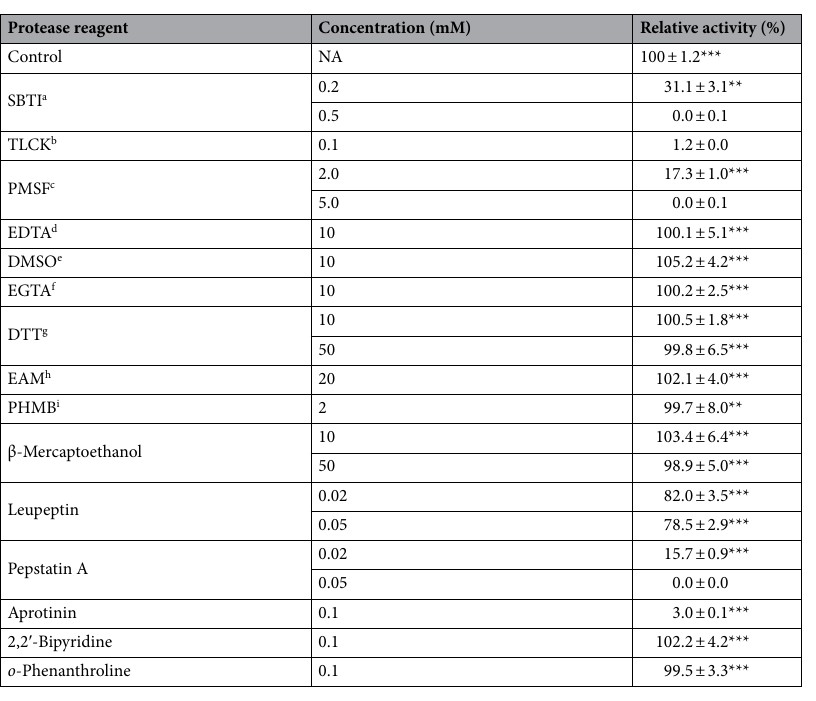
Table 3. Impact of the protease inhibitors on the proteolytic activity of UcB5. These reagents were incubated with 1.0 × 10 –4 mg of the chromogenic substrate S7388 and 2.0 × 10 –3 mg of UcB5 in 100 µl of 20 mM Tris–HCl buffer (pH 8.0) for 3 min at 37 °C. The released pNA was quantified at A 405 nm and the proteolytic activity in the absence of reagents was considered 100% activity. a Soybean trypsin inhibitor; b tosyl-lysyl-chloromethylketose; c phenylmethylsulfonylfluoride; d ethylenediaminetetraacetic acid; e dimethyl sulfoxide; f ethylene glycol-O,O ′ -bis-[2-amino-ethyl]-N, N, N ′ , N ′ -tetraacetic acid; g 1,4-dithiothreitol; h aminobenzamidine ethyl acetimidate; i p-hydroxymercuribenzoate. There was a statistically significant difference among the protease reagents as determined by one-way analysis of variance (ANOVA) (F calculated = 369.69, F tabled = 2.4, P = 0.000). *P significant at P < 0.05; **P highly significant at P < 0.01; ***P very highly significant at P < 0.001; Student’s one-sample